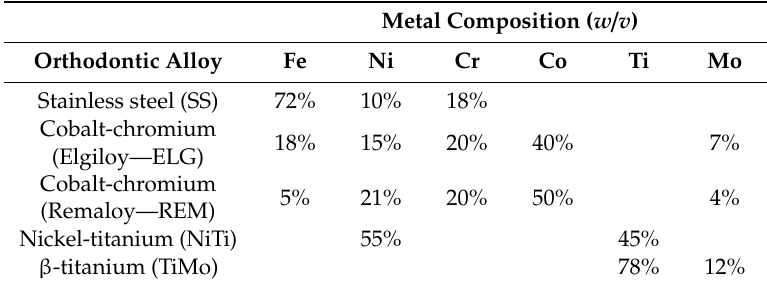
Table 2. Metal ion ratios for orthodontic alloys adapted from the manufacturer’s (Dentaurum, Ispringen, Germany) material safety data sheet